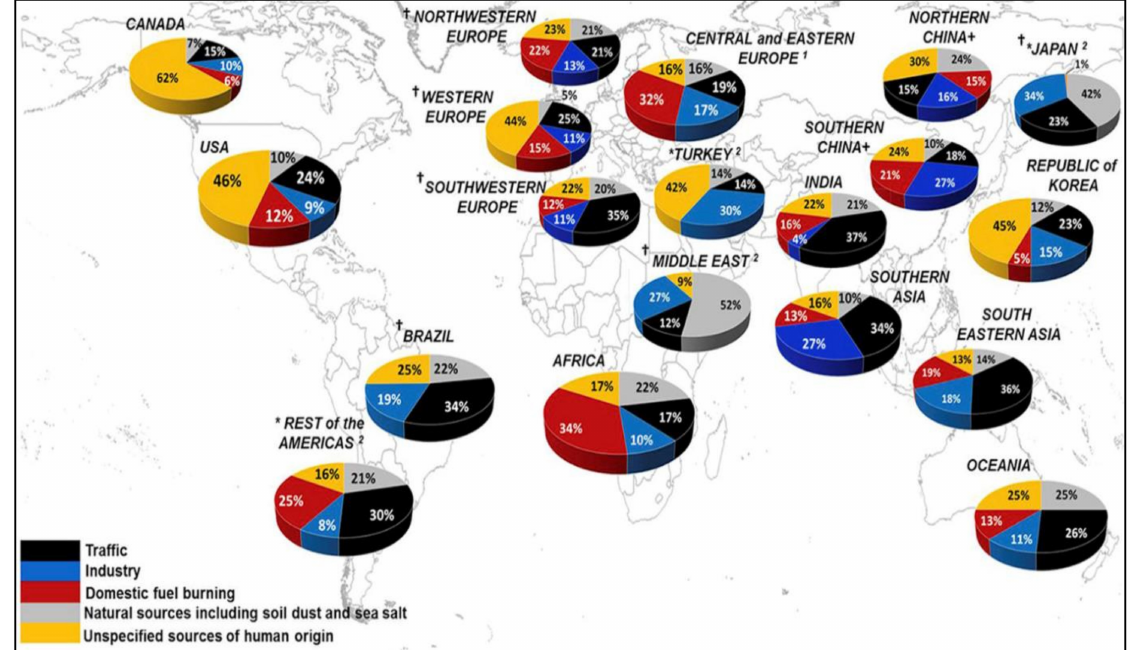
Figure 1. Population-weighted averages for relative source contributions to total PM2.5 in urban sites. *, † regions in which (*) unspecified sources of human origin and (†) domestic fuel burning sources have not been assessed. 1 Based only on one study including domestic fuel burning, and therefore only provides indicative results. 2 Based only on two studies, and therefore only provides indicative results. Source: Karagulian et al.